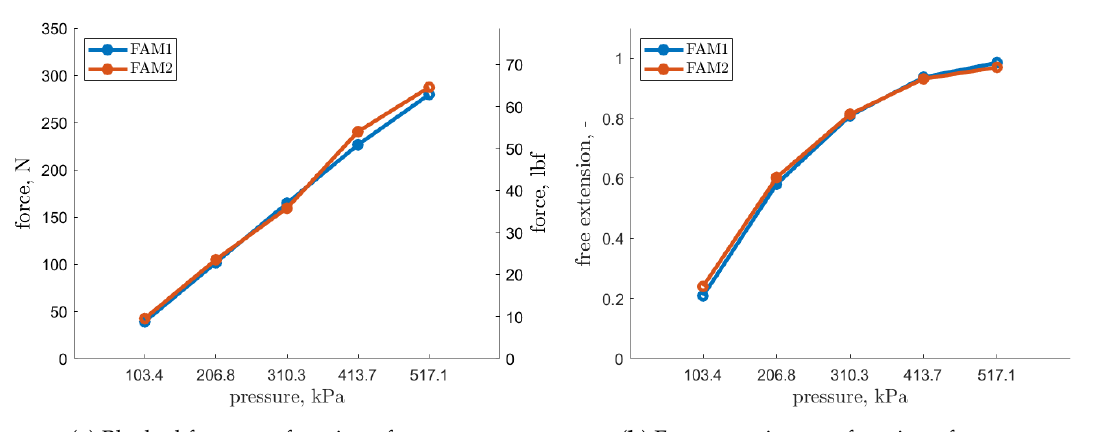
Figure 7. For the two extensile FAMs, the blocked force trend is strongly linear, and increases with pressure. Free extension also increases with pressure to reach saturation above 517.1kPa (75psi). The blue and orange lines correspond to FAM1 and FAM2,